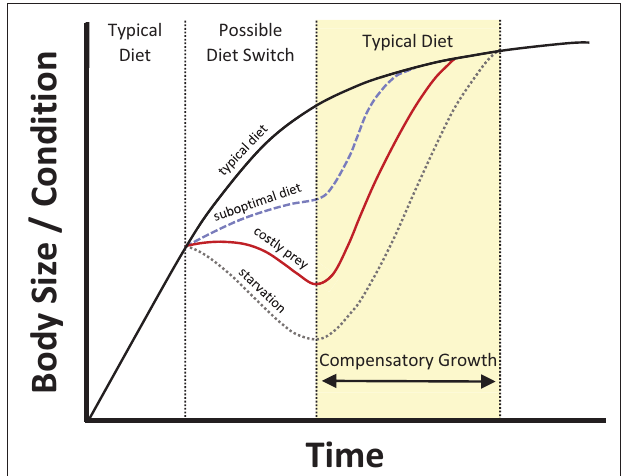
FIGURE 1 | Illustration of possible negative consequences of costly-prey consumption, and the rapid offsetting of costs via compensatory growth. Costly-prey consumption might often entail strong fitness costs relative to other prey items (especially in the absence of mechanisms I or II, Box 1 ), but still offer more energetic return than starvation, with compensatory growth providing a generalized response to counteract periods of growth